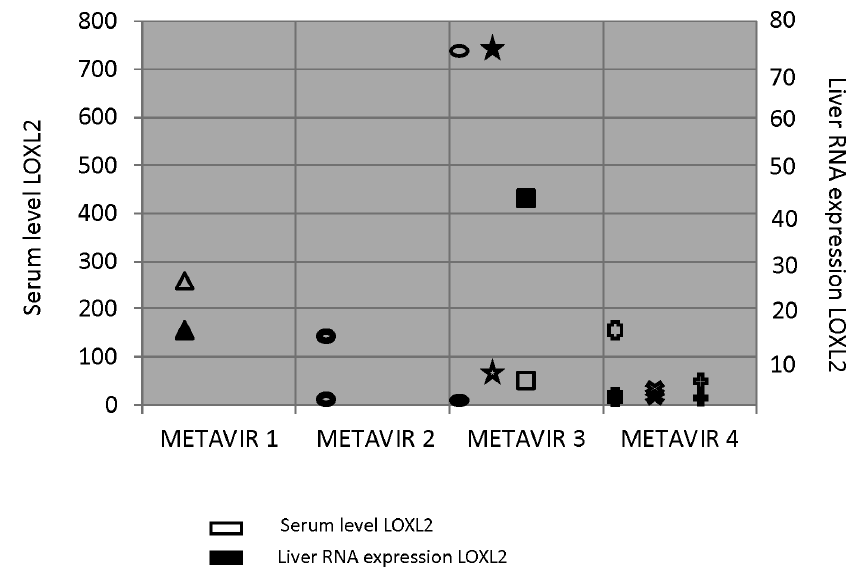
Figure 4. Serum and tissue expression of LOXL2 in eight patients. Each symbol represents a case. Filled symbols represent liver LOXL2 RNA expression, and unfilled symbols represent LOXL2 serum level. Table 1. Baseline demographics and clinical characteristics. Data are presented as no. (%) or mean ± standard deviation. Abbreviations: BMI, body mass index; ALT, alanine aminotransferase; AST, aspartate aminotransferase; GGT, gamma glutamyl transferase; HCC, hepatocellular carcinoma; INR, international normalized ratio.